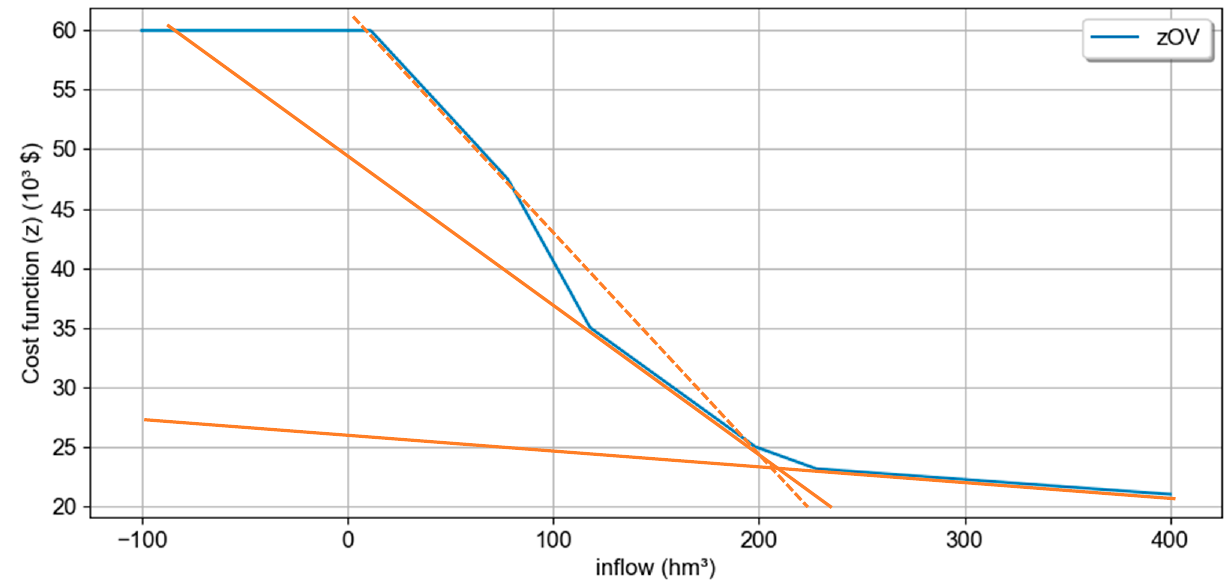
Figure 4. Cost function (zOV) (10 3 $) per inflow (hm 3 ) with the optimality cuts (orange) approximat- ing the cost function.